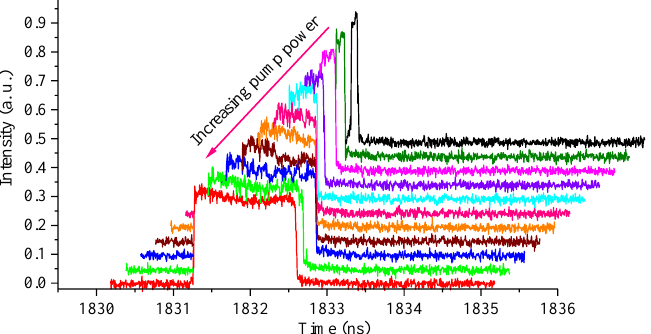
Figure 4. Various mode-locking statuses with respect to different PC angle of ( a ) 13 degrees, ( b ) 28 degrees and ( c ) 41 degrees. The pulse duration can also be changed by increasing the pump power. As the PC is fixed and the pump power is raised from 200 mW to 800 mW, the pulse duration is increased from 36 ps to 1.2 ns, as shown in Figure 5. Square pulses are observed over a pump power of 350 mW.